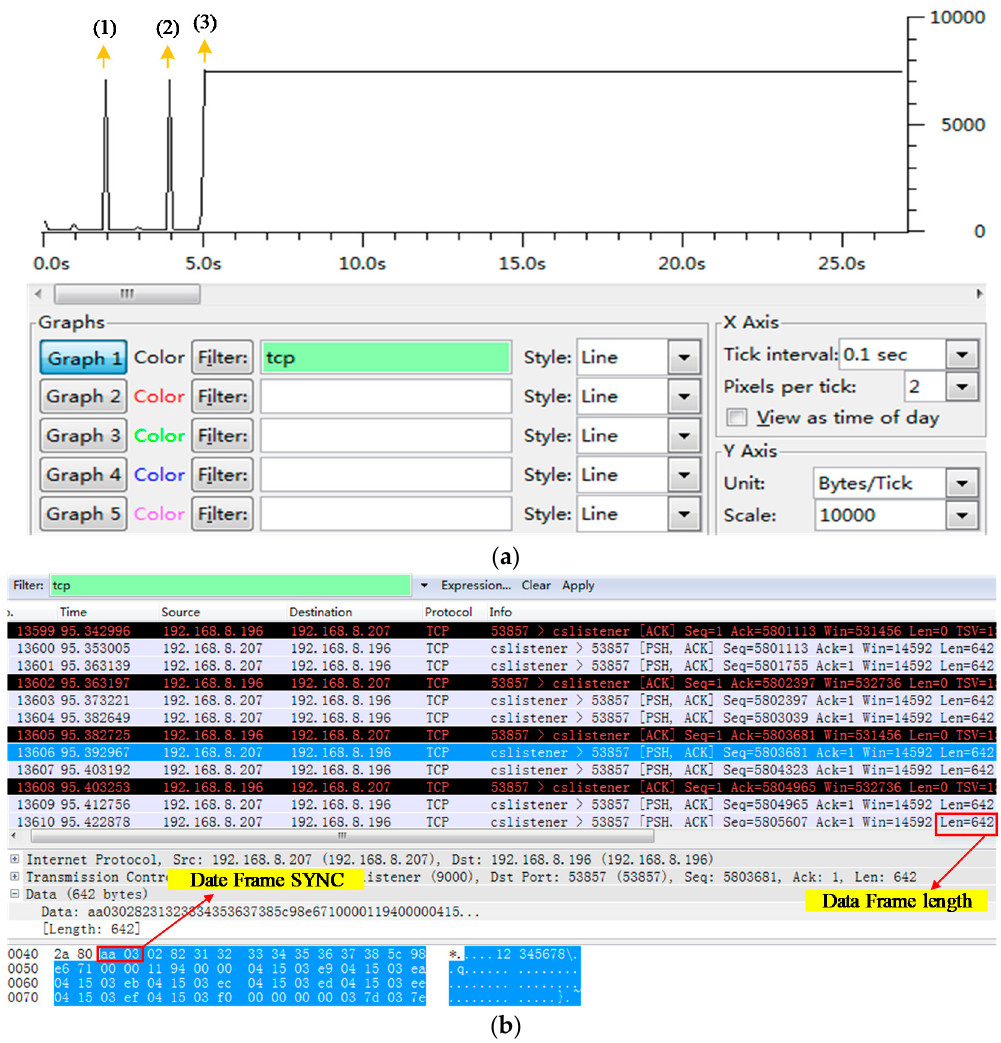
Figure 10. Standard GB/T 26865.2-2011 protocol operation results. ( a ) Communication data traffic; ( b ) data frame.